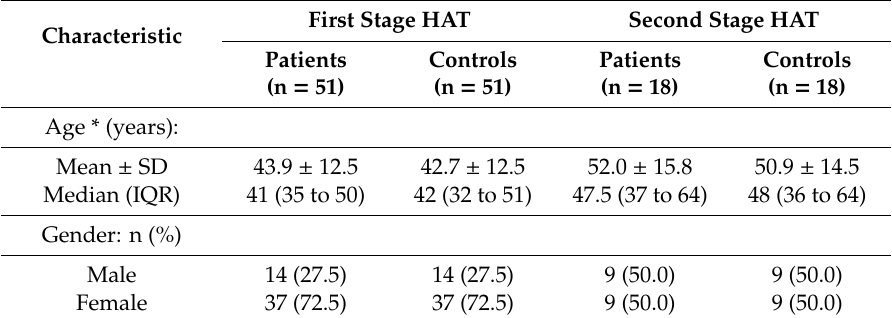
Figure 1. Flow chart of the Human African Trypanosomiasis (HAT) study. Table 1. Descriptive characteristics for first and second stage HAT patients and their